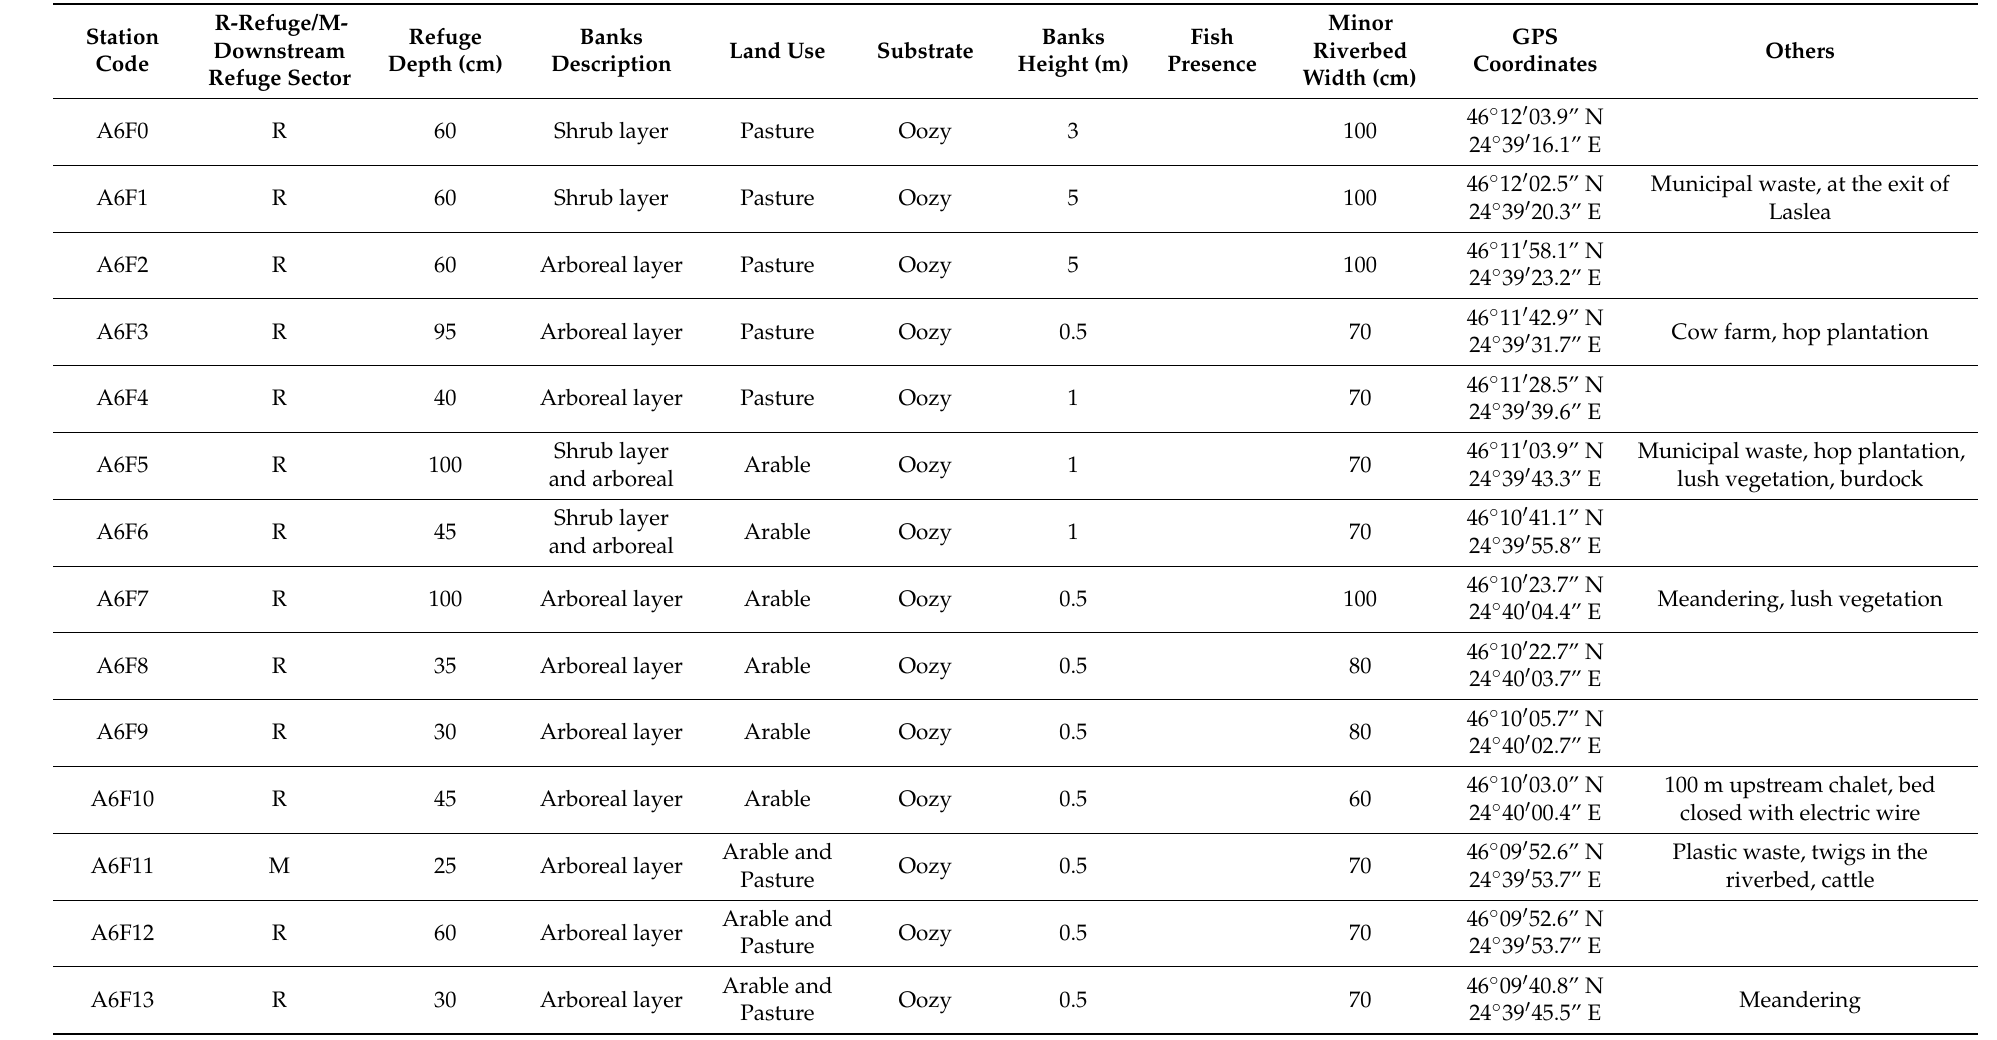
Table A6. Flore¸sti/Fel¸ta River Habitat